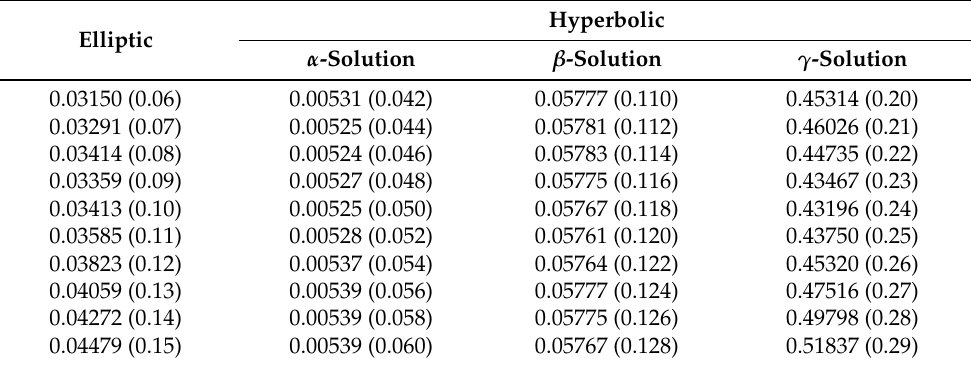
√ Table 7. The MSE of kernel regression method evaluated at bandwidth h (presented in parenthesis) in estimating the critical collapse response function g ( z ) = b 2 based on a training sample of size n = 100.